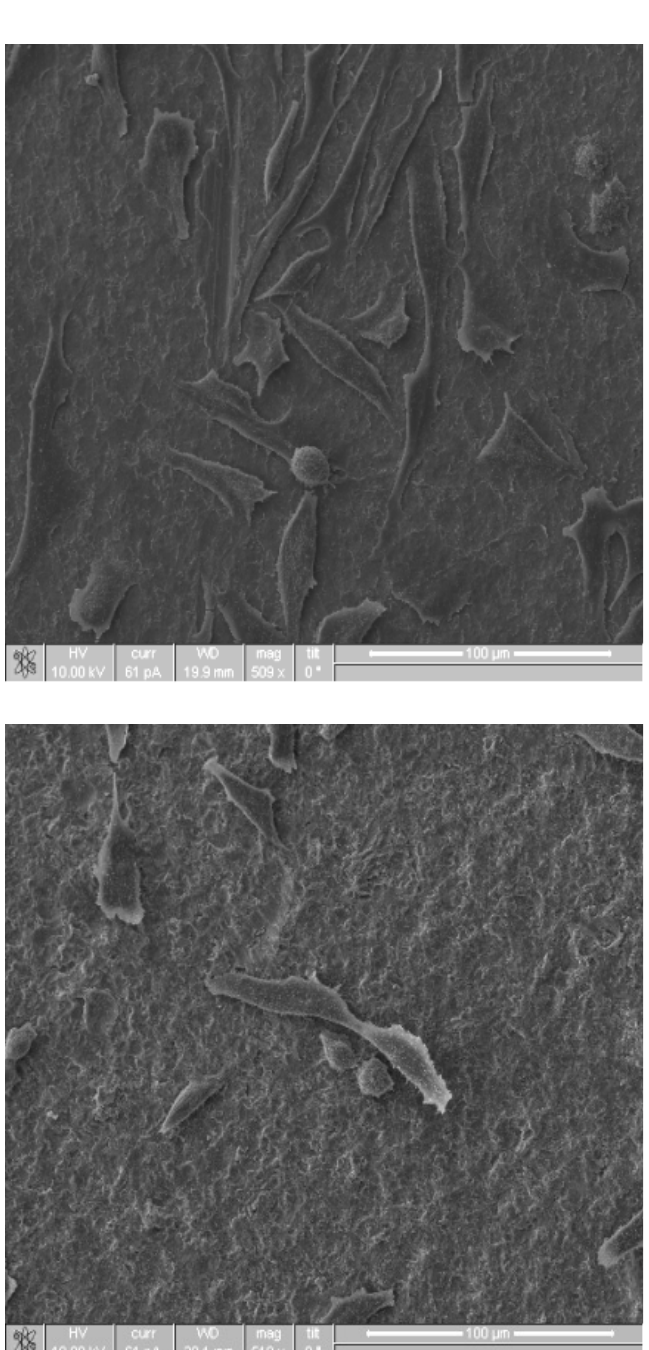
Figure 8. MG-63 osteoblasts cultured on 106 treatment × 500 magnification and (×500